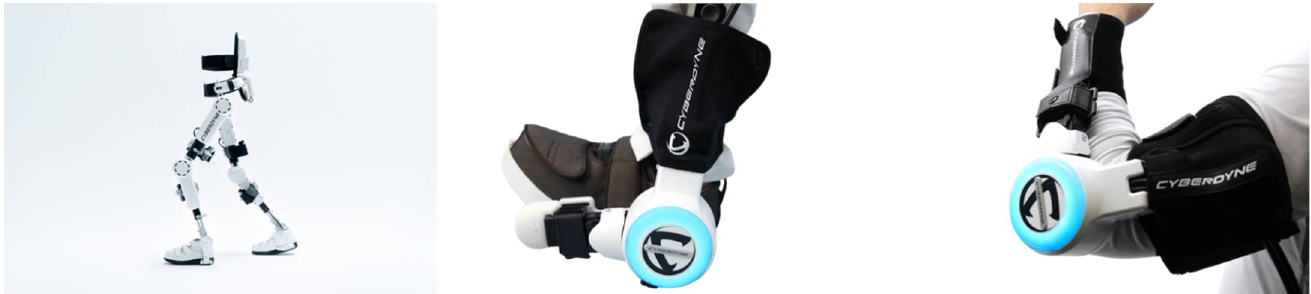
Figure 7. Hybrid Assistive Limb (HAL TM , Prof. Sankai, CYBERDYNE Inc.), ( left ) Lower Limb Type; ( middle ) Single Joint Type- ankle joint attachment; ( right ) Single Joint Type- elbow joint.